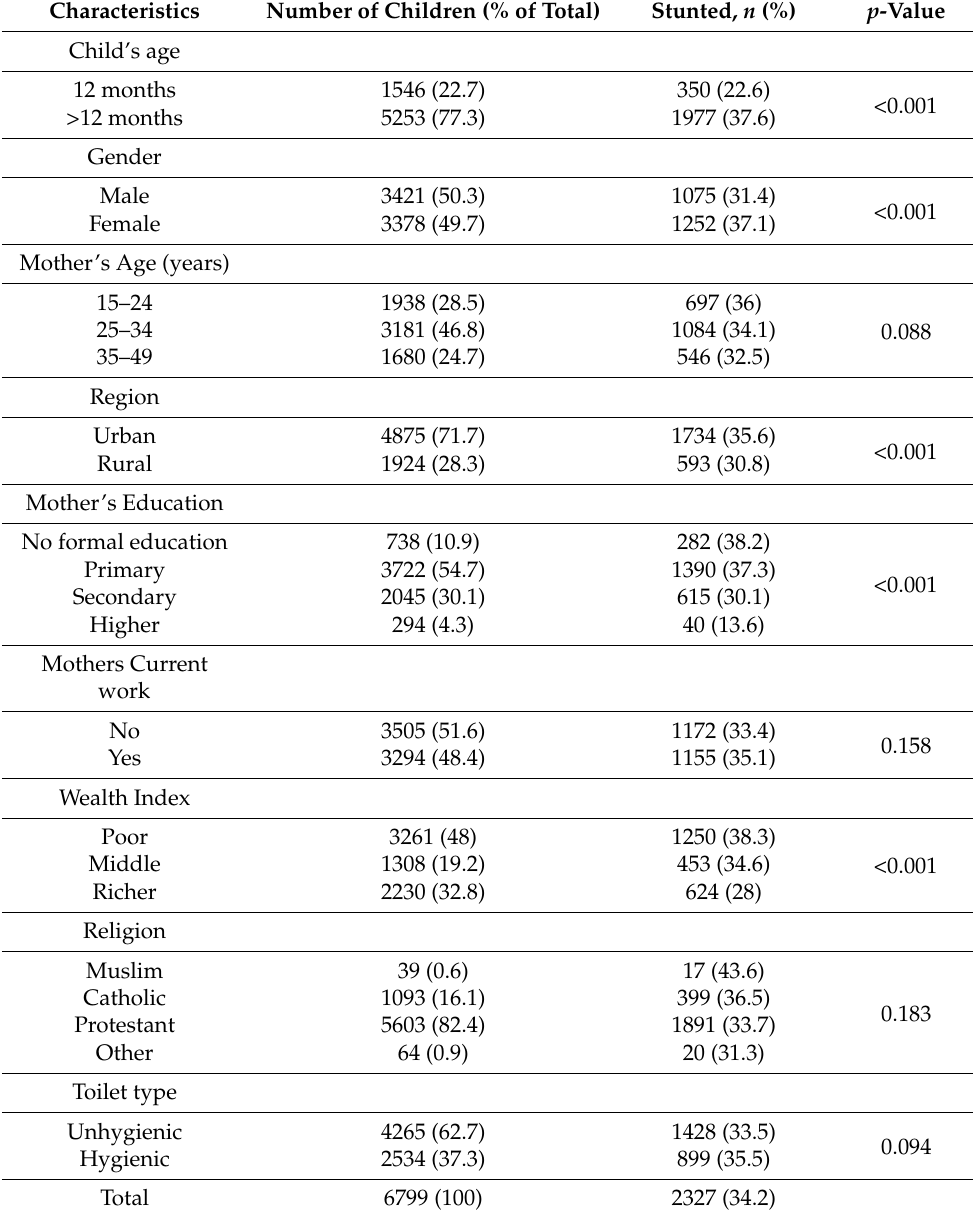
Table 1. Percent of stunted children by background